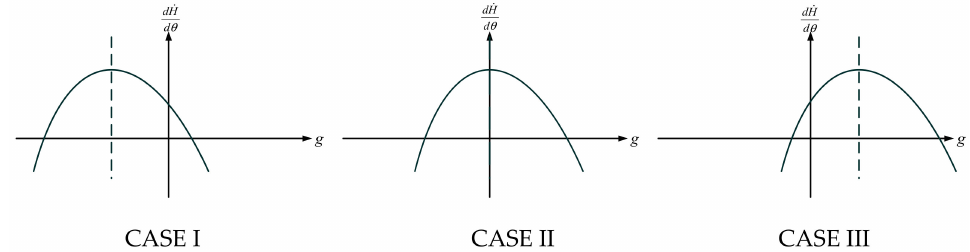
Figure 5. Three cases according to function